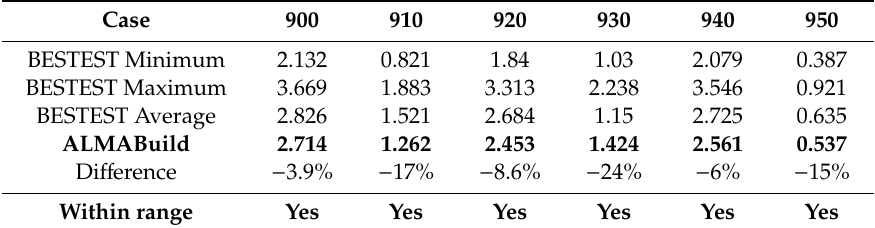
Table 6. Annual Cooling Load (MWh) obtained for non-free-float heavyweight BESTEST cases compared with the minimum and maximum threshold values indicated by